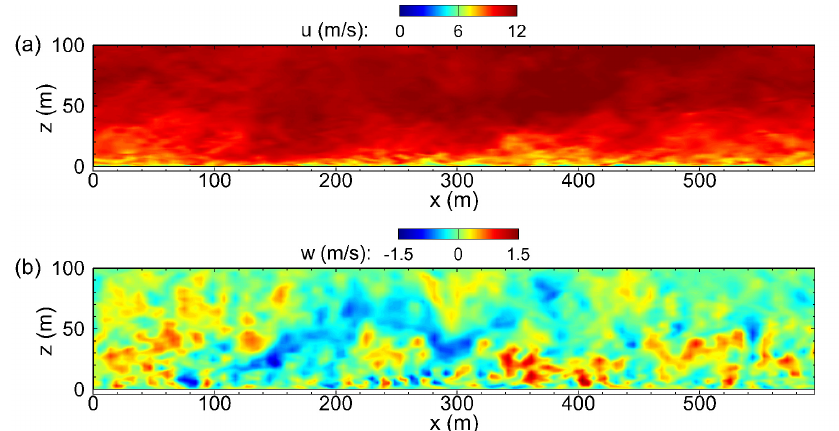
Figure 3. Instantaneous flow field on the ( x , z ) -plane across the center of the surface release region for the flat-surface case: ( a ) streamwise velocity u ; ( b ) vertical velocity w